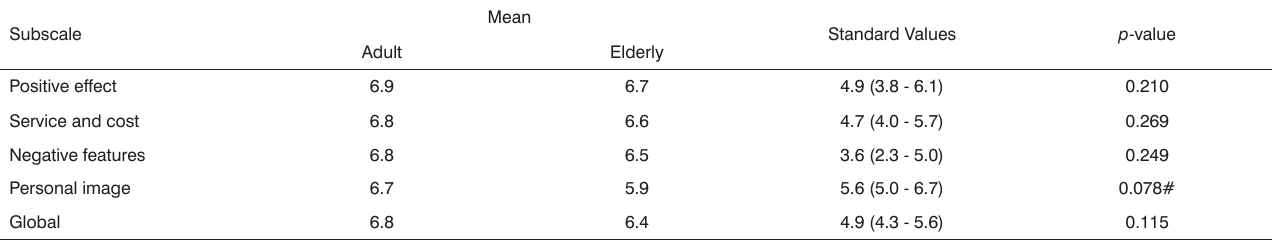
Table 4. Comparison between global and subscale scores for age groups (adult and elderly